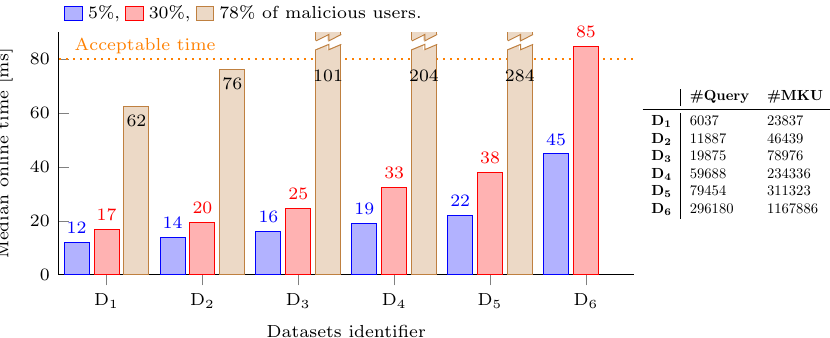
Figure 13. Evolution of the median online time on datasets with fixed volume of MKUs and varying ratio of queries affected to malicious users, and thus processed online. The table on the right side describes the volume of queries and MKUs for each